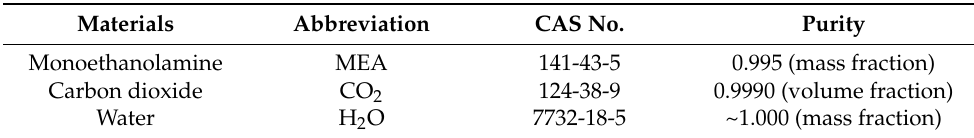
Table 1. Table of materials for the